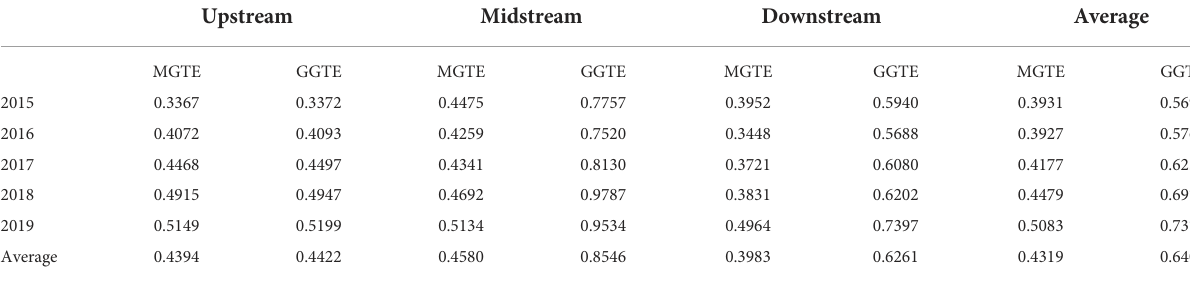
TABLE 6 MGTE value and GGTE value of each link of the industrial chain after adjustment in 2015-2019.